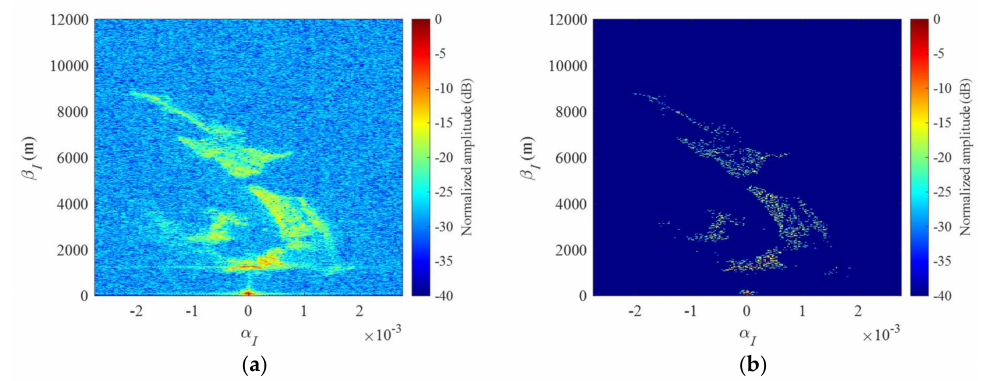
Figure 9. Imaging results of the mountainous area in Besançon obtained by ( a ) 2D IFFT and ( b ) 2D FISTA; the abscissa and ordinate are α I and β I ,